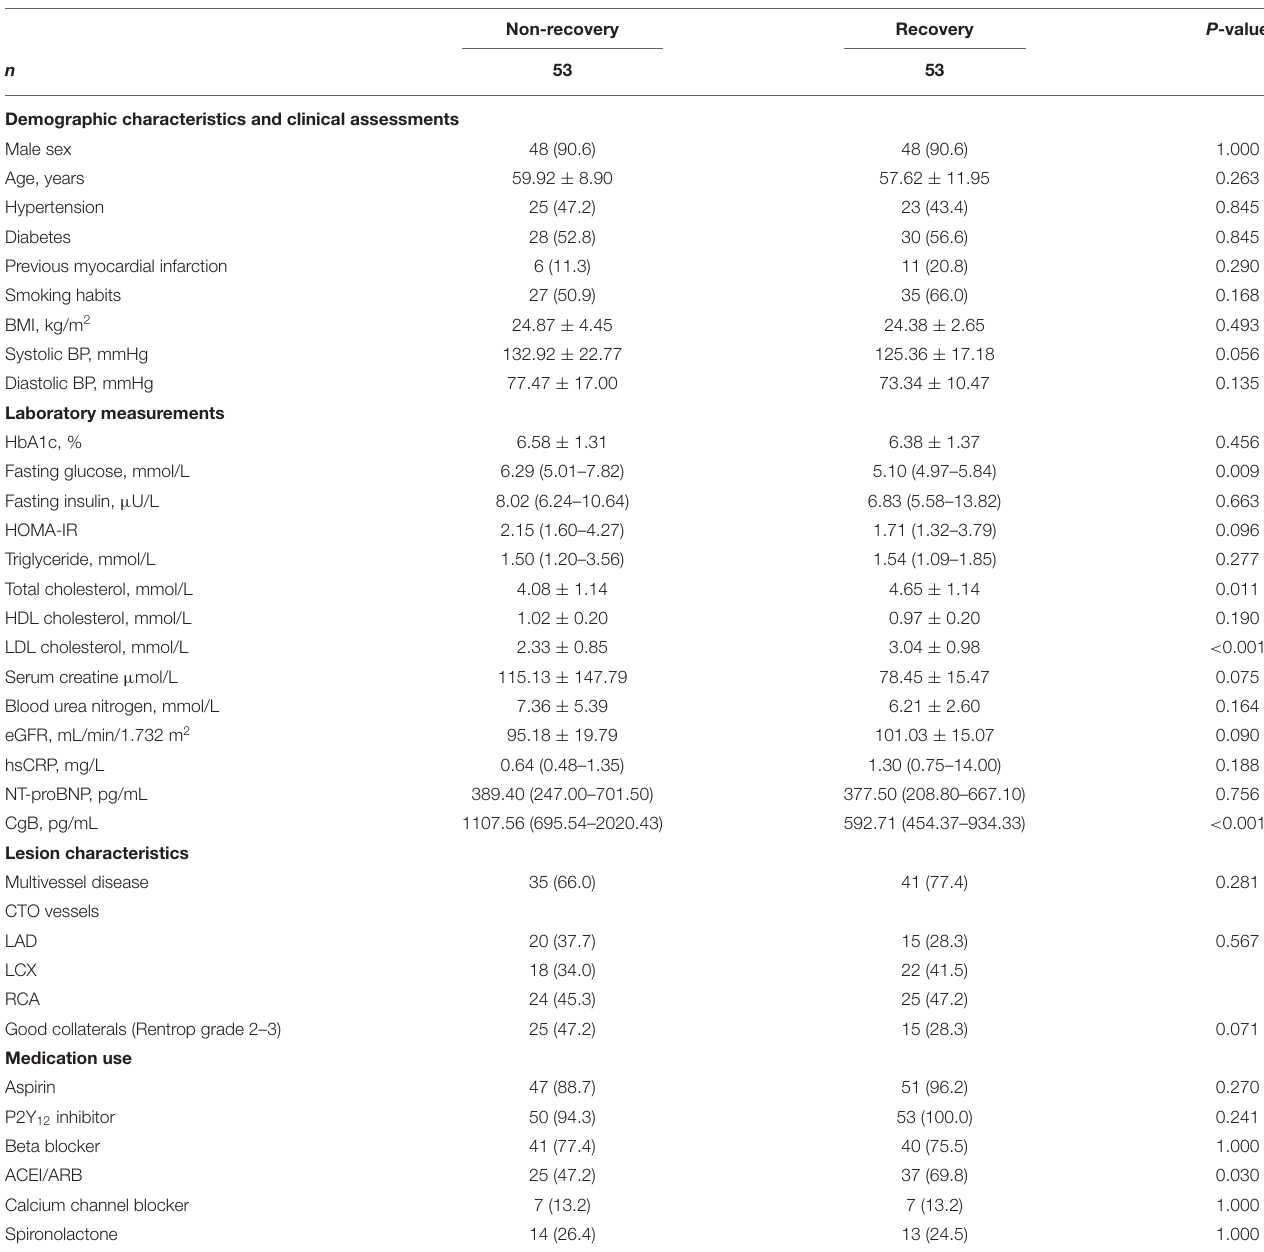
TABLE 1 | Baseline demographic and clinical